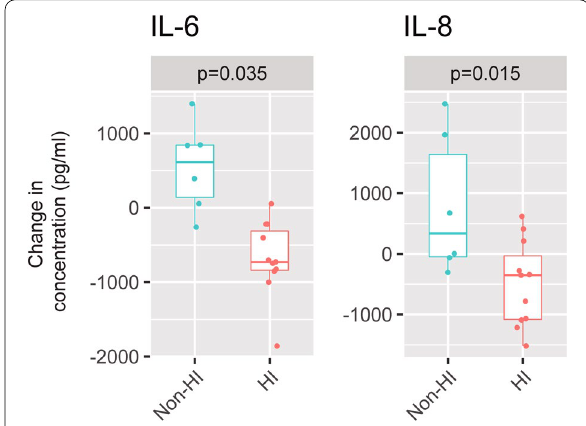
Fig. 3 Change in IL‑6 and IL‑8 from ventilation with 6 ml/kg predicted body weight (PBW) to 3 ml/kg PBW in hyperinflamed and non‑hyperinflamed patients (defined using a threshold in IL‑6 levels during ventilation with 6 ml/kg PBW of 680 pg/ml). The lower and upper hinges correspond to the first and third quartiles (the 25th and 75th percentiles). The upper and lower whiskers extend from the hinge to the largest or smallest value no further than 1.5 times the interquartile range from the hinge. Individual values are shown as points. P values were obtained using an analysis of covariance (ANCOVA) test. IL interleukin